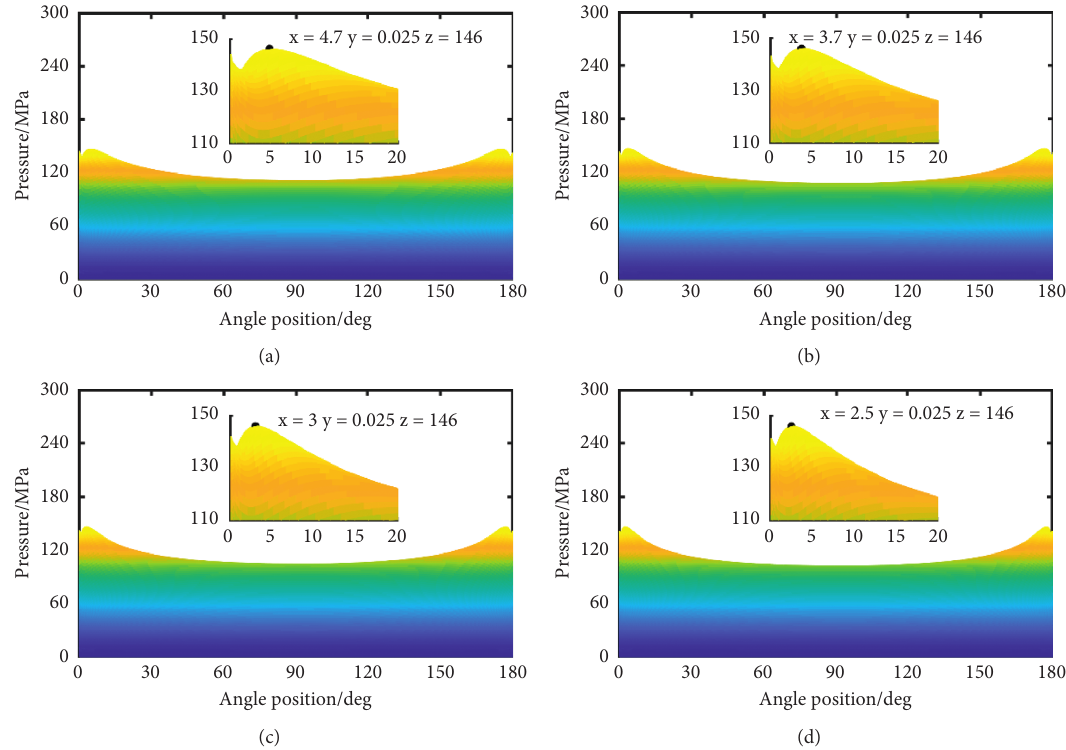
Figure 6: The effect of speed on the local maximum pressure distribution of the oil film at p � 10MPa. (a) n � 700 r/min; (b) n � 900 r/min; (c) n � 1100 r/min; (d) n � 1300